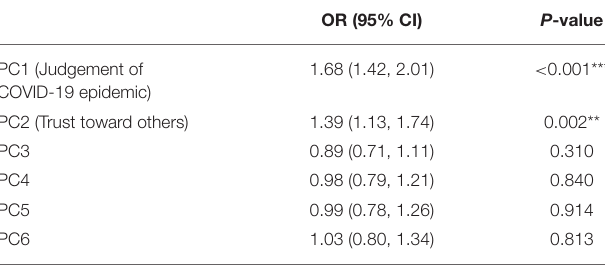
TABLE 5 | Multivariable associations between principal components of psychological factors and unnecessary dental attendance. OR (95%